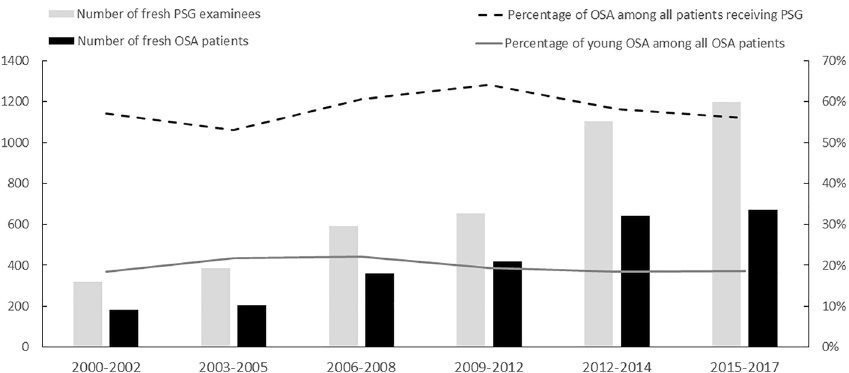
Figure 1. Young patients with OSA constituted a substantial portion of all patients with OSA, which did not vary significantly year to year (p value for trend = 0.162). The diagnosis of OSA was defined as apnea–hypopnea index ≥ 5 while hypopnea was defined as a discernible reduction in airflow accompanied by a decrease in oxyhemoglobin saturation of 4% before 2007 and a 30% decrease in nasal pressure with desaturation > 4% after 2007.